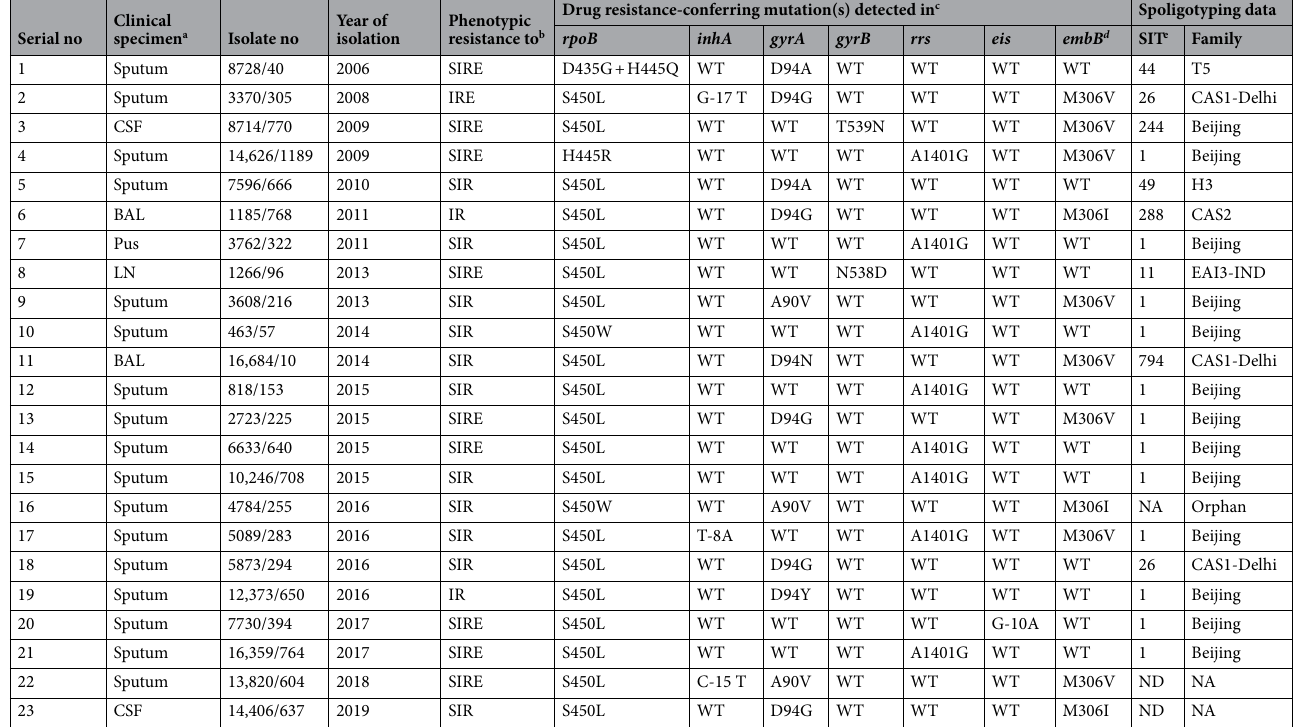
Table 3. Clinical details and phenotypic and molecular characterization of 23 MDR-TB isolates by GenoType MTBDR sl version 1 and GenoType MTBDR sl version 1 showing genotypic resistance to FQs or SLIDs a . a FQs, fluoroquinolones, SLIDs, second-line injectable drugs; CSF, cerebrospinal fluid; BAL, bronchoalveolar lavage; LN, lymph node. b S, streptomycin; I, isoniazid; R, rifampin, E, ethambutol. c All isolates contained S315T mutation in katG gene. d embB codon 306 mutations only; e SIT, shared international type; NA, not available; ND, not